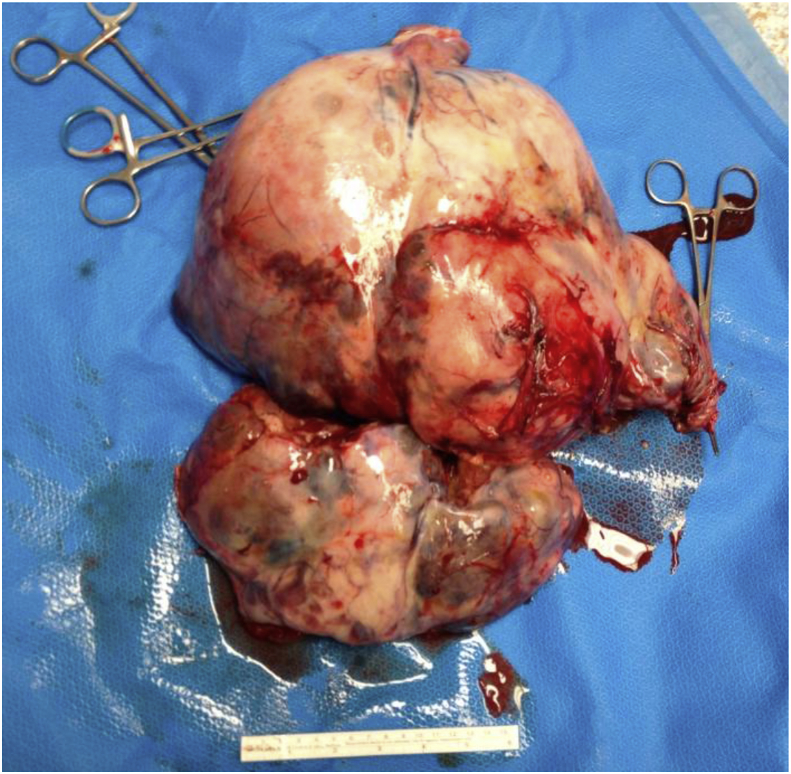
Operative specimen.